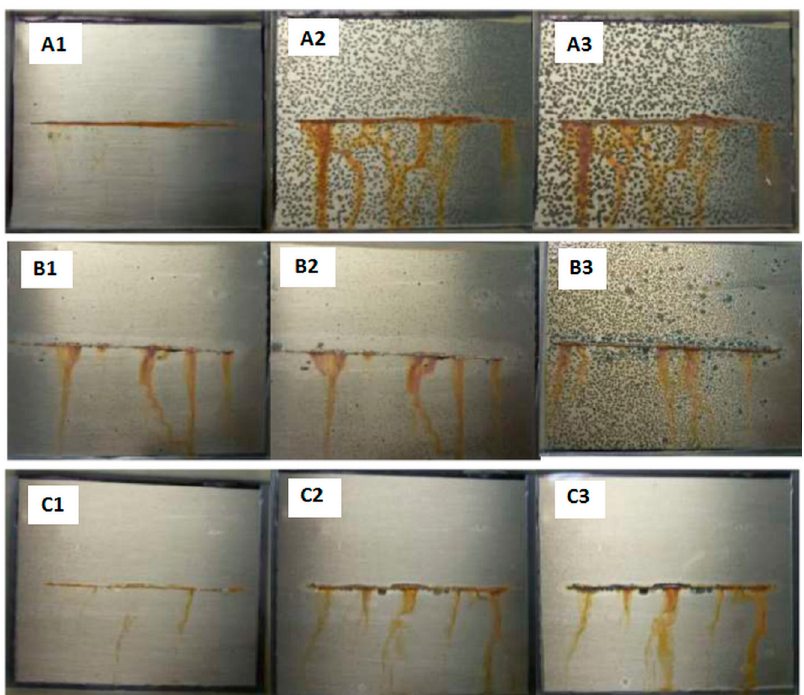
Figure 2. Salt spray test results for the ( A1 – A3 ) blank epoxy, ( B1 – B3 ) graphene oxide (GO) / epoxy and ( C1 – C3 ) graphene oxide was successfully modified with polyamidoamine dendrimer (GO-PAMAM) / epoxy composites after ( A1 , B1 , C1 ) 7 days, ( A2 , B2 , C2 ) 14 days, and ( A3 , B3 , C3 ) 21 days exposure to the salt spray test (Adapted with permission from ref. [77] 2020 Elsevier).